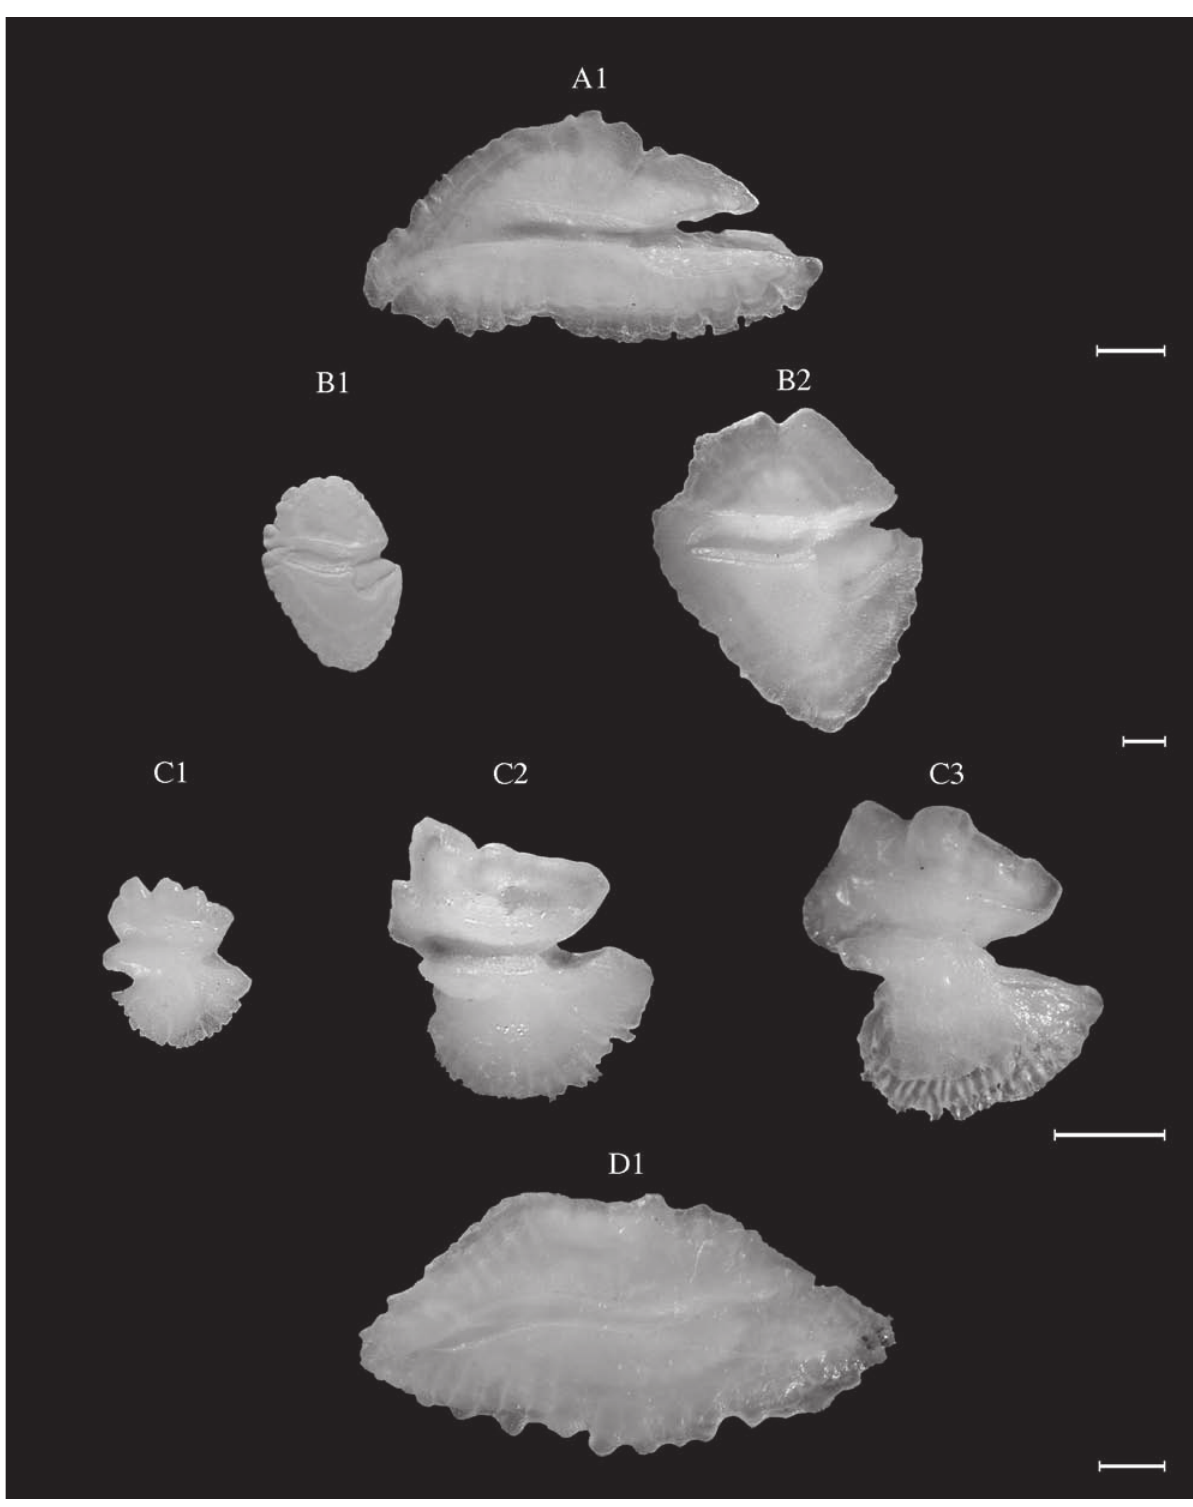
Fig. 87. – Stromateus fiatola (NEA). TL: A1, 30.5. Antigonia capros (CEA). TL: B1, 6.8 cm; B2, 11.0 cm. Capros aper . TL: C1, 6.0 cm (NEA); C2, 9.5 cm (WM); C3, 11.7 cm (CEA). Psettodes bennetti (NEA). TL: D1, 25.8 cm. Scale bar = 1